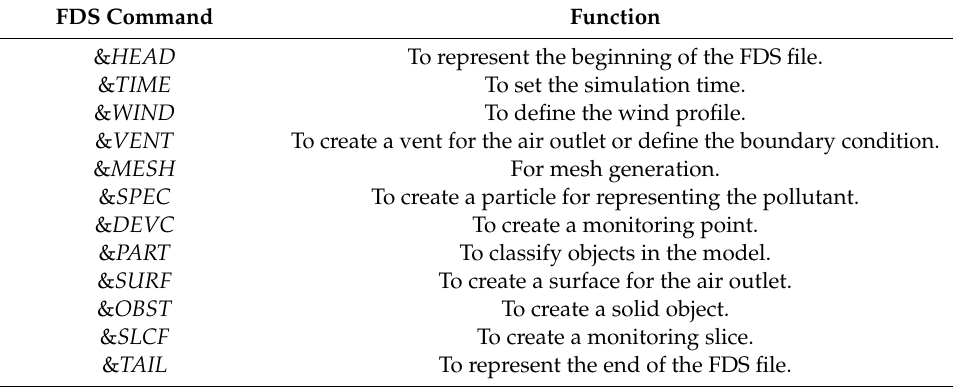
Table A1. Commands commonly used in FDS for the simulation of pollutant